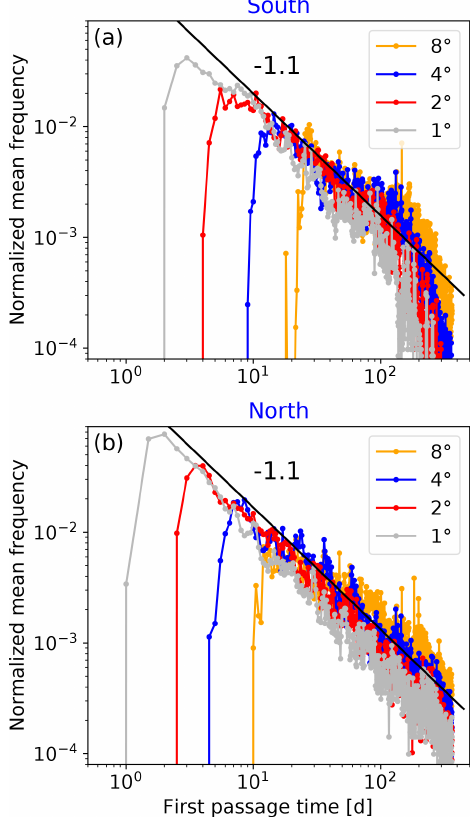
Figure 8. Normalized empirical frequency distribution of the first passage time (FPT) for the (a) southern subset and (b) northern sub- set of advected parcels on a double-logarithmic scale. Four different boundaries are shown at 1, 2, 4 and 8 ◦ west from the initial posi- tions of the tracers. The straight black line parallel to the envelopes illustrates a power law with an exponent value of around − 1 . 1.